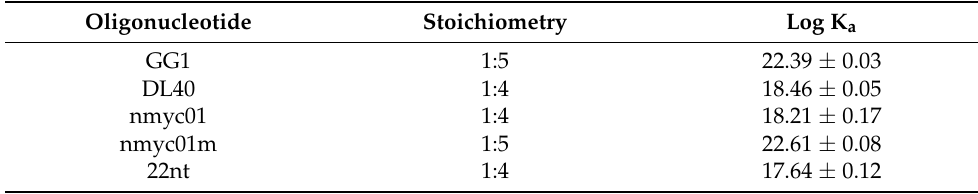
Table 4. Log K a constants and assumed stoichiometry for escholidine:DNA complex.